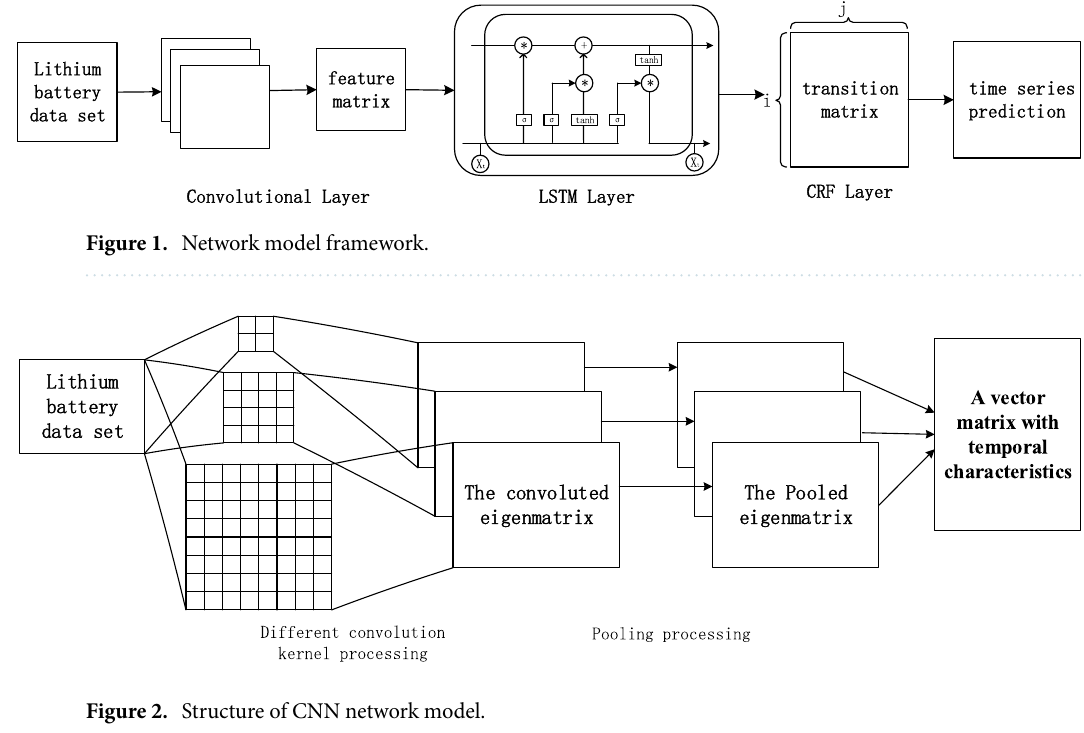
Figure 2. Structure of CNN network